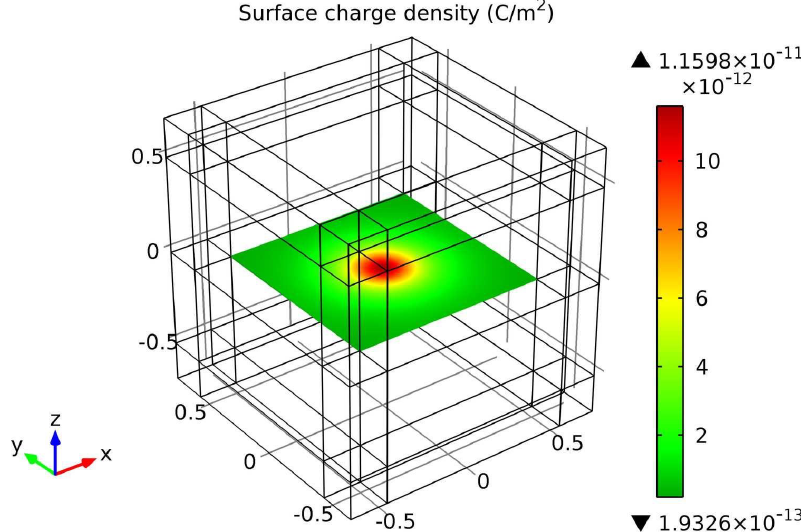
Figure 6. Numerically simulated absolute value of the electric field for a single current source I with considered values I = 1 A and ξ = (0, 0, −20 cm) T .